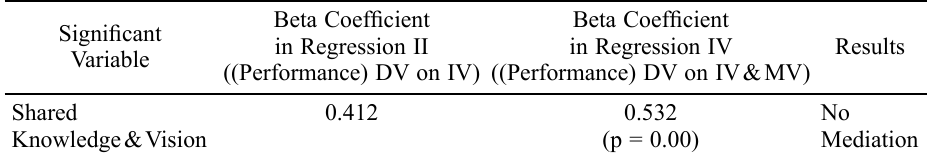
Table 5. Summary of mediating effects of